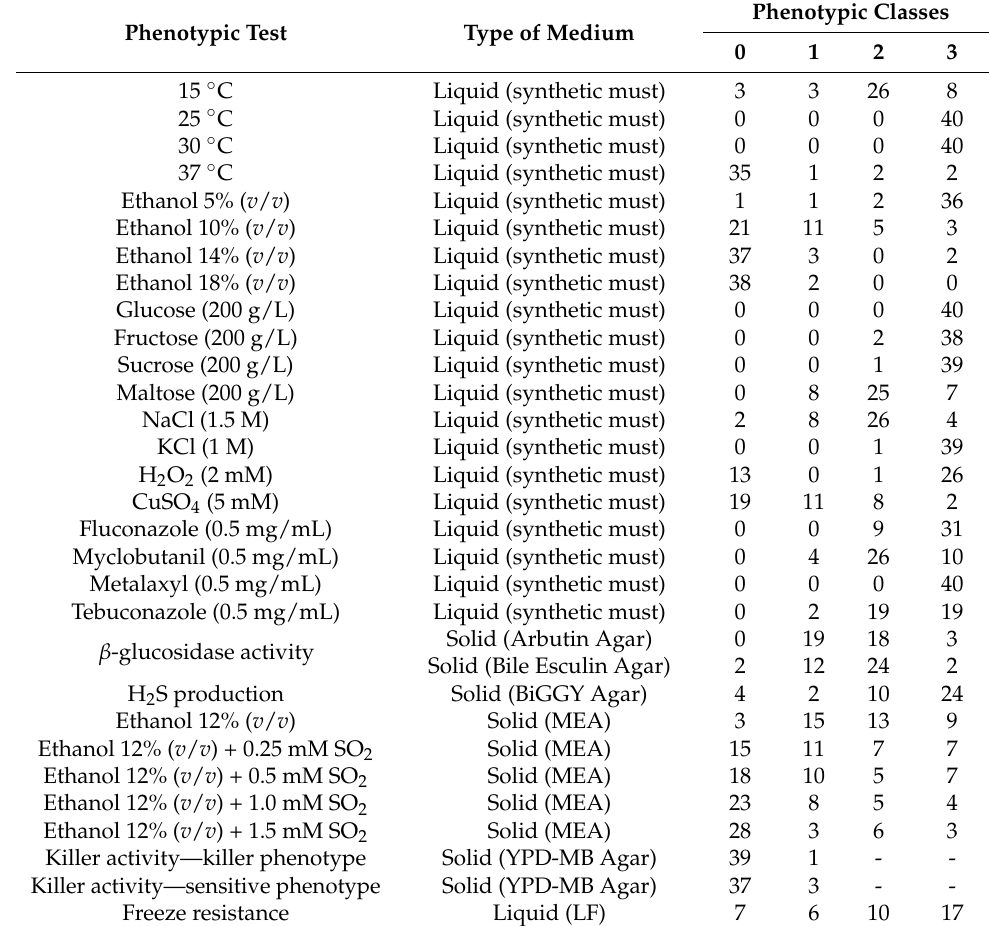
Table 1. Number of strains belonging to different phenotypic classes, as result of the screening comprising 31 tests, regarding values of optical density (Class 0: DO 640 = 0.1; Class 1: 0.2 < DO 640 < 0.4; Class 2: 0.5 < DO 640 < 1.0; Class 3: DO 640 > 1.0), killer phenotype (Class 0: neutral; Class 1: killer or sensitive phenotype), change of medium color (arbutin and BiGGY media), halo size (esculin medium) and cell viability after freezing.